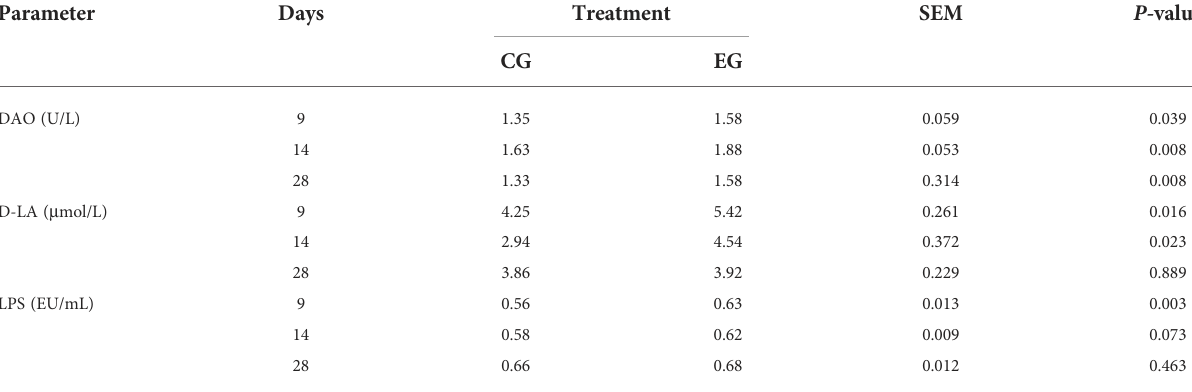
TABLE 3 Effect of the Escherichia coli challenge on the serum DAO, D-LA, and LPS content of ducks ( n = 6). Parameter